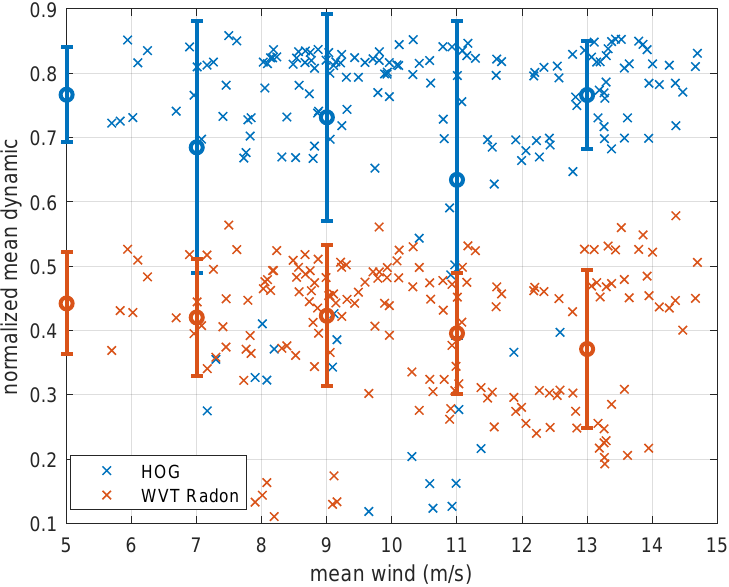
Figure 17. HOG and WVT Radon dynamics in function of wind speed.